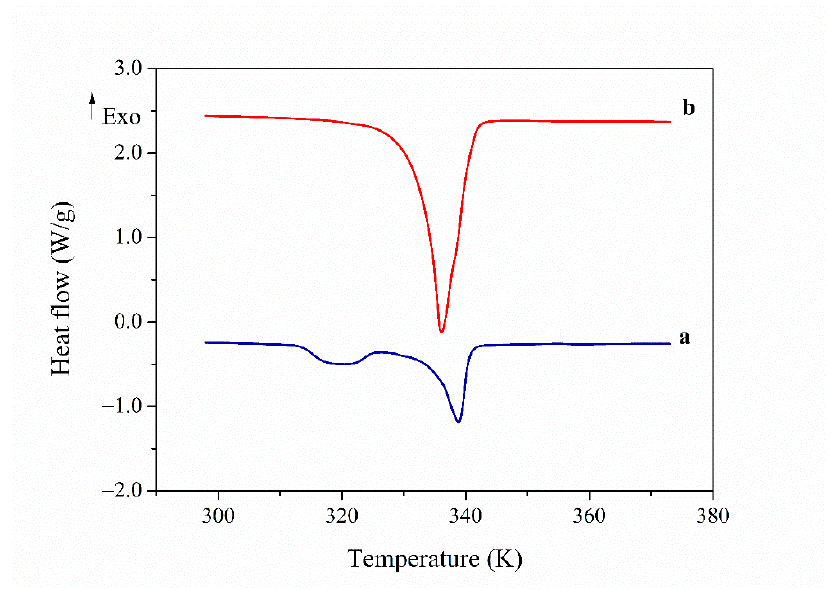
Figure 2. Differential Scanning Calorimetry (DSC) thermogram on first heating of: ( a ) PAZE40; ( b ) PAZE100.